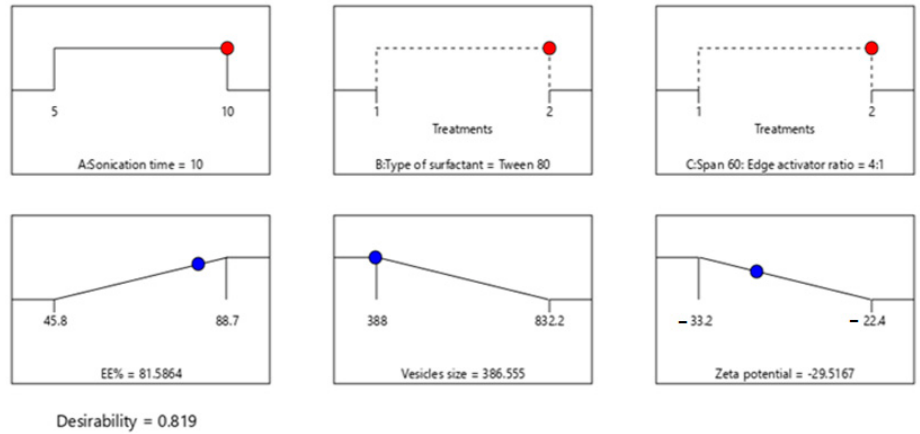
Figure 3. The composition of the optimized formula and its expected responses.